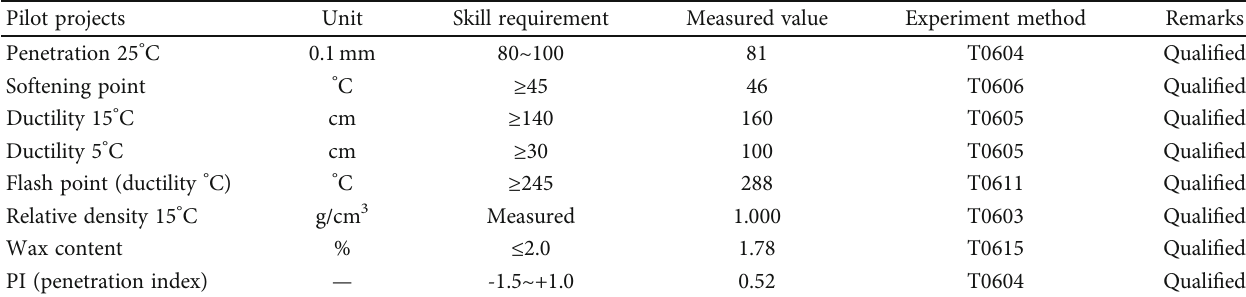
Table 1: 90# matrix asphalt properties and technical requirements.